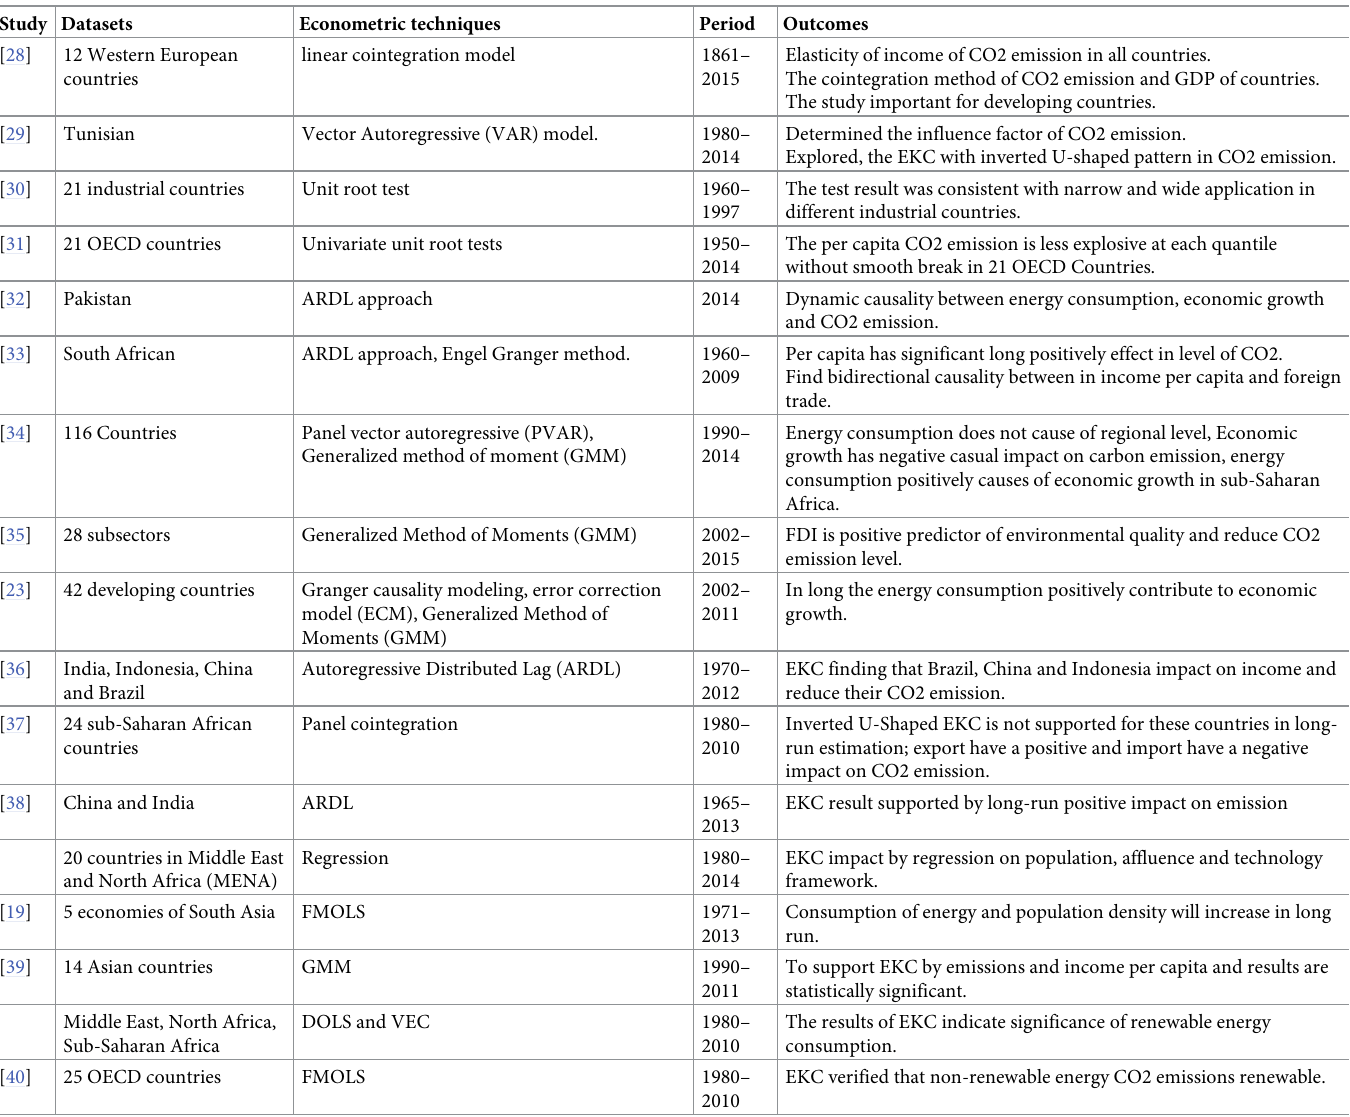
Table 1. Literature review of economic growth and CO2